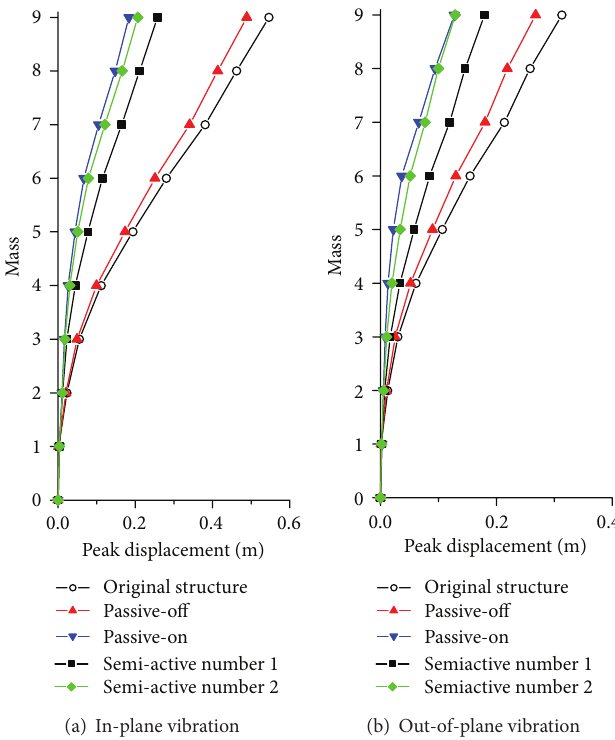
Figure 16: Comparison of control performance of peak displacement.